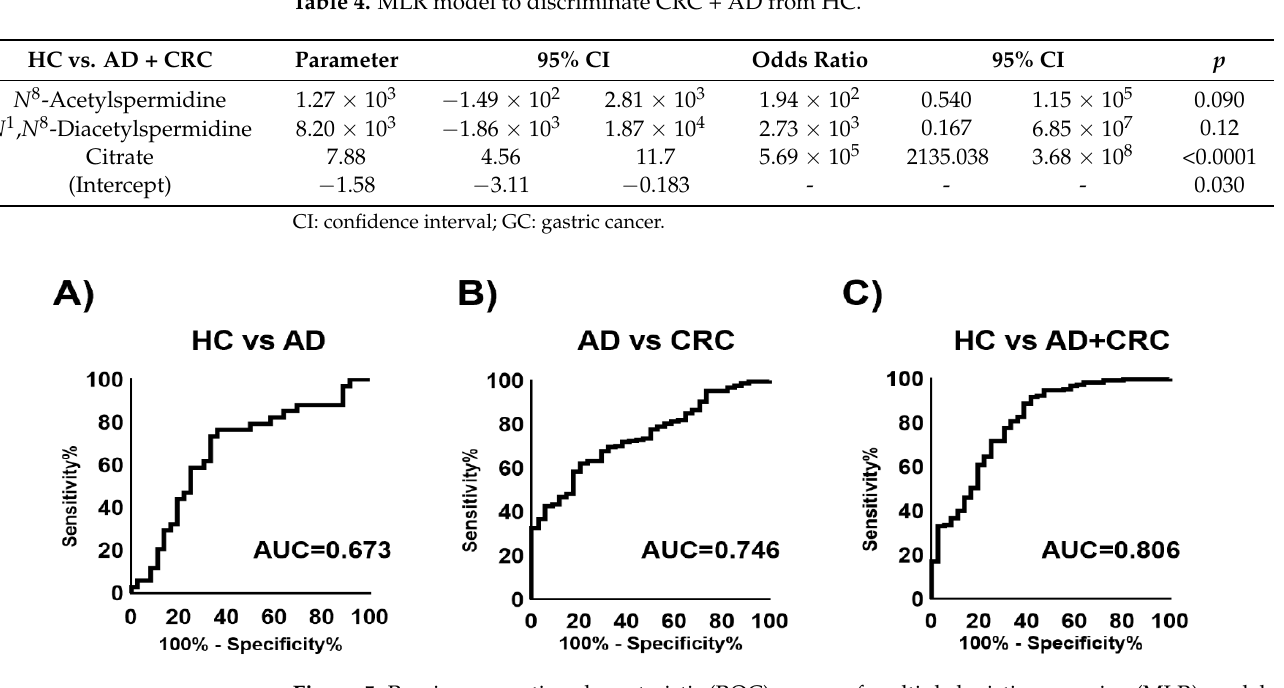
Figure 5. Receiver operating characteristic (ROC) curves of multiple logistic regression (MLR) models using integrated datasets (data 1 and data 2). ( A ) HC vs. AD, ( B ) AD vs. CRC, and ( C ) HC vs. AD + CRC. The metabolites and parameters of the MLR models are listed in Tables 2–4.